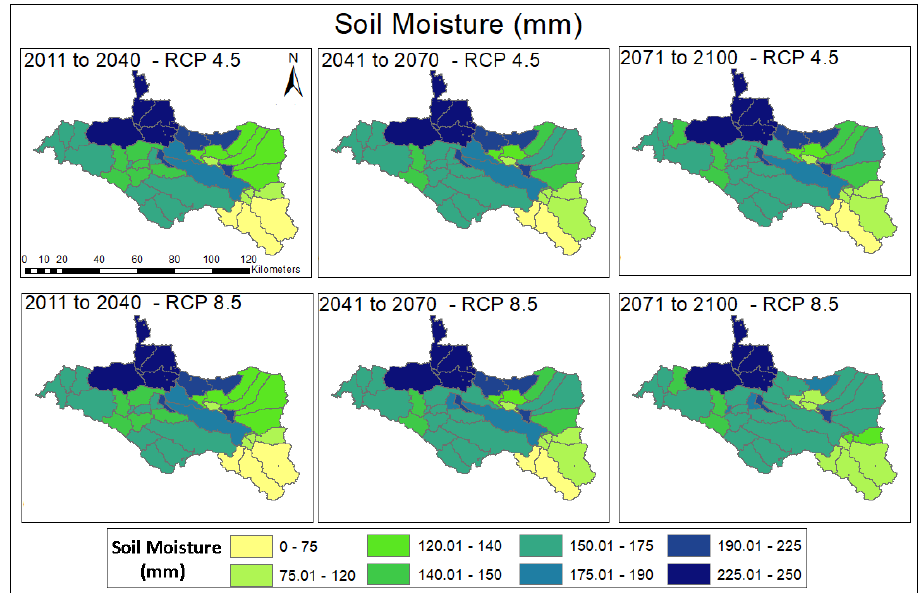
Figure 11. Spatial distribution of soil moisture for near, mid-, and far future of RCP 4.5 and 8.5 emission scenarios.